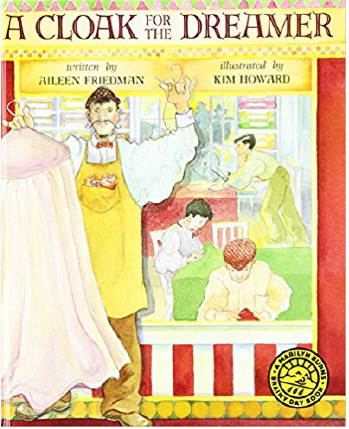
Figure 3. A Cloak for the